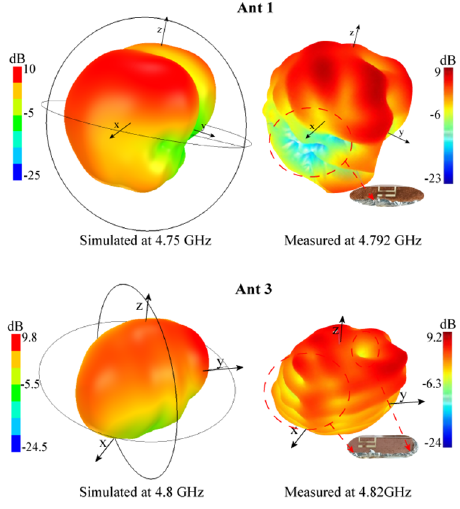
Figure 17. Simulated and measured 3-D radiation patterns of Ant 1.